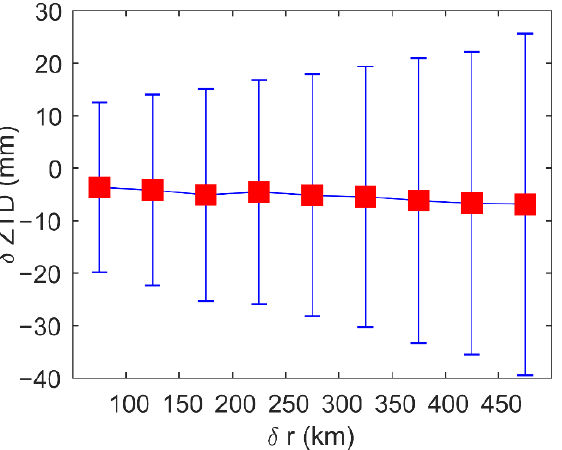
Figure 9. δr ’s variations in residual ZTDs of matched atmPrf and gnsZTD in 2008. Red square mark